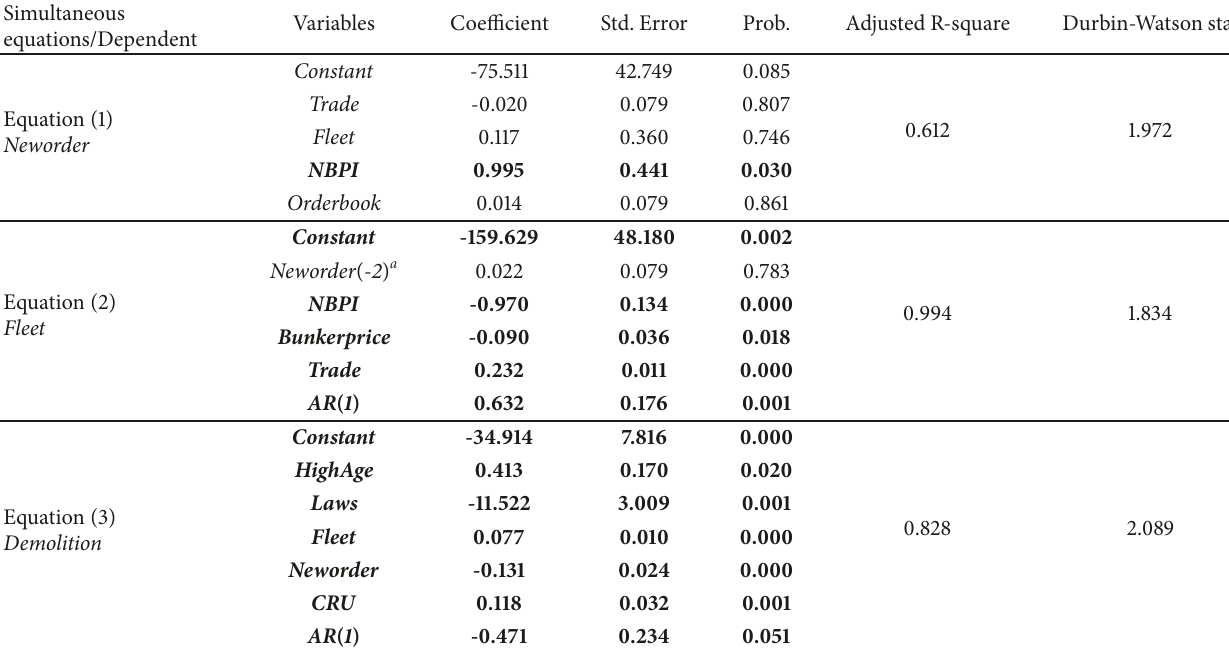
Table 2: Estimated results of the SEM for bulker ship.